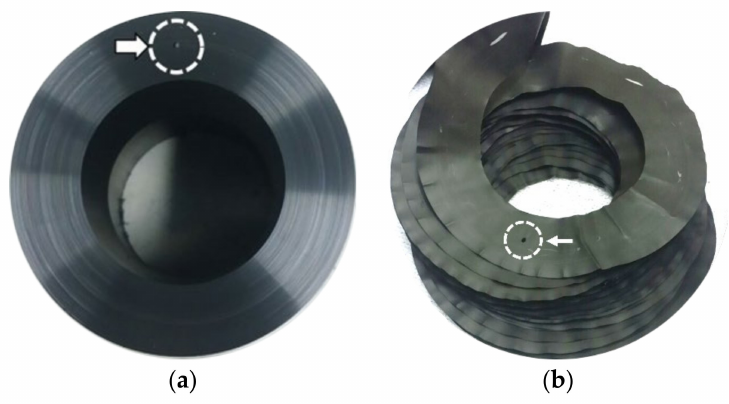
Figure 1. The 110 SDR 5 PE pipe, ( a ) 1 mm locator hole, ( b ) 50 µ m thick whole pipe cross-section